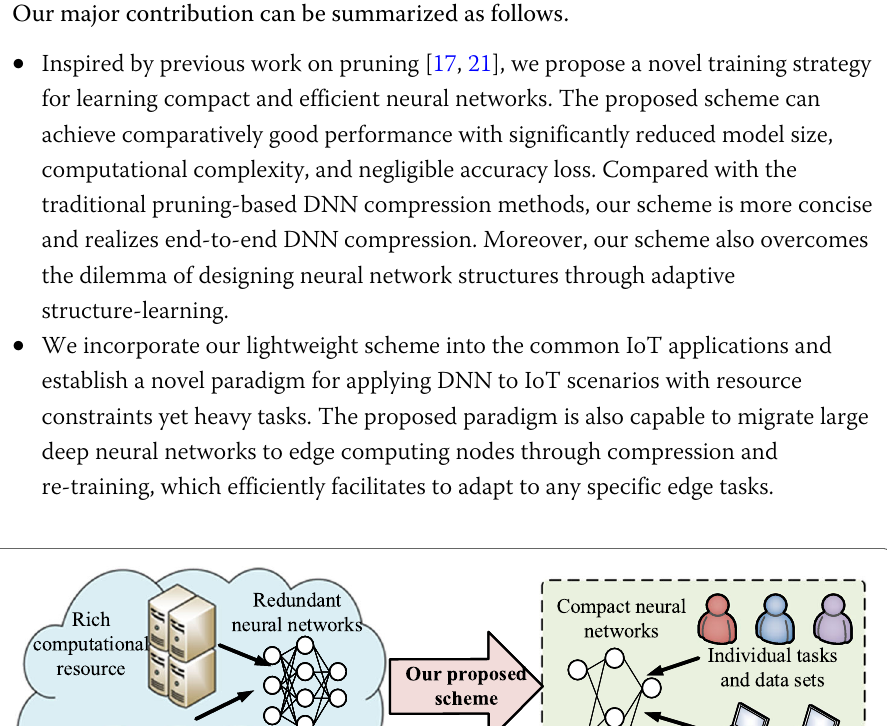
their corresponding kernels and train the preserved weights after obtaining the compact structure.